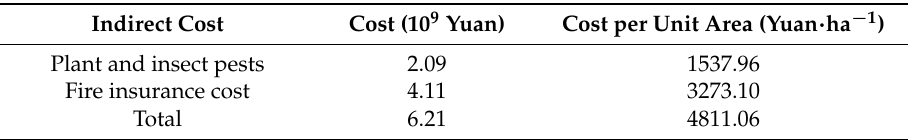
Table 6. Risk cost of forest in Yanqing District in